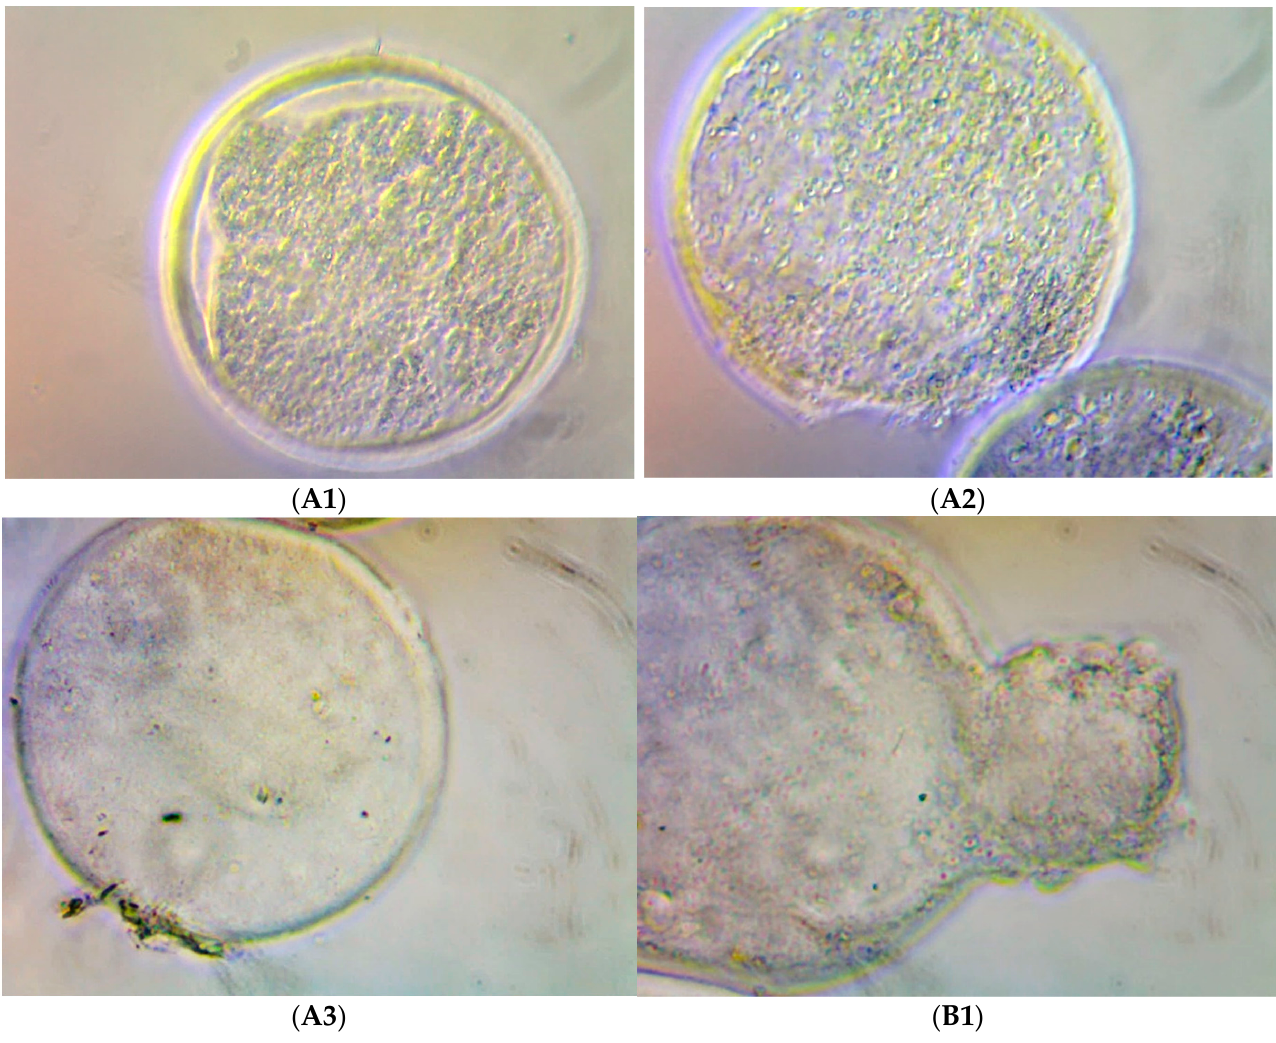
Figure 3. Illustrations from the contrast microscope at 200 × magnification: ( A1 , A2 ) blastocysts from Experiment 1; ( A3 ) expanded blastocysts from Experiment 2; ( B1 ) hatched blastocyst from Experiment 2. All DAB-stained in vitro bovine embryos were cultivated without rHGAL-1 supplementation (control group).